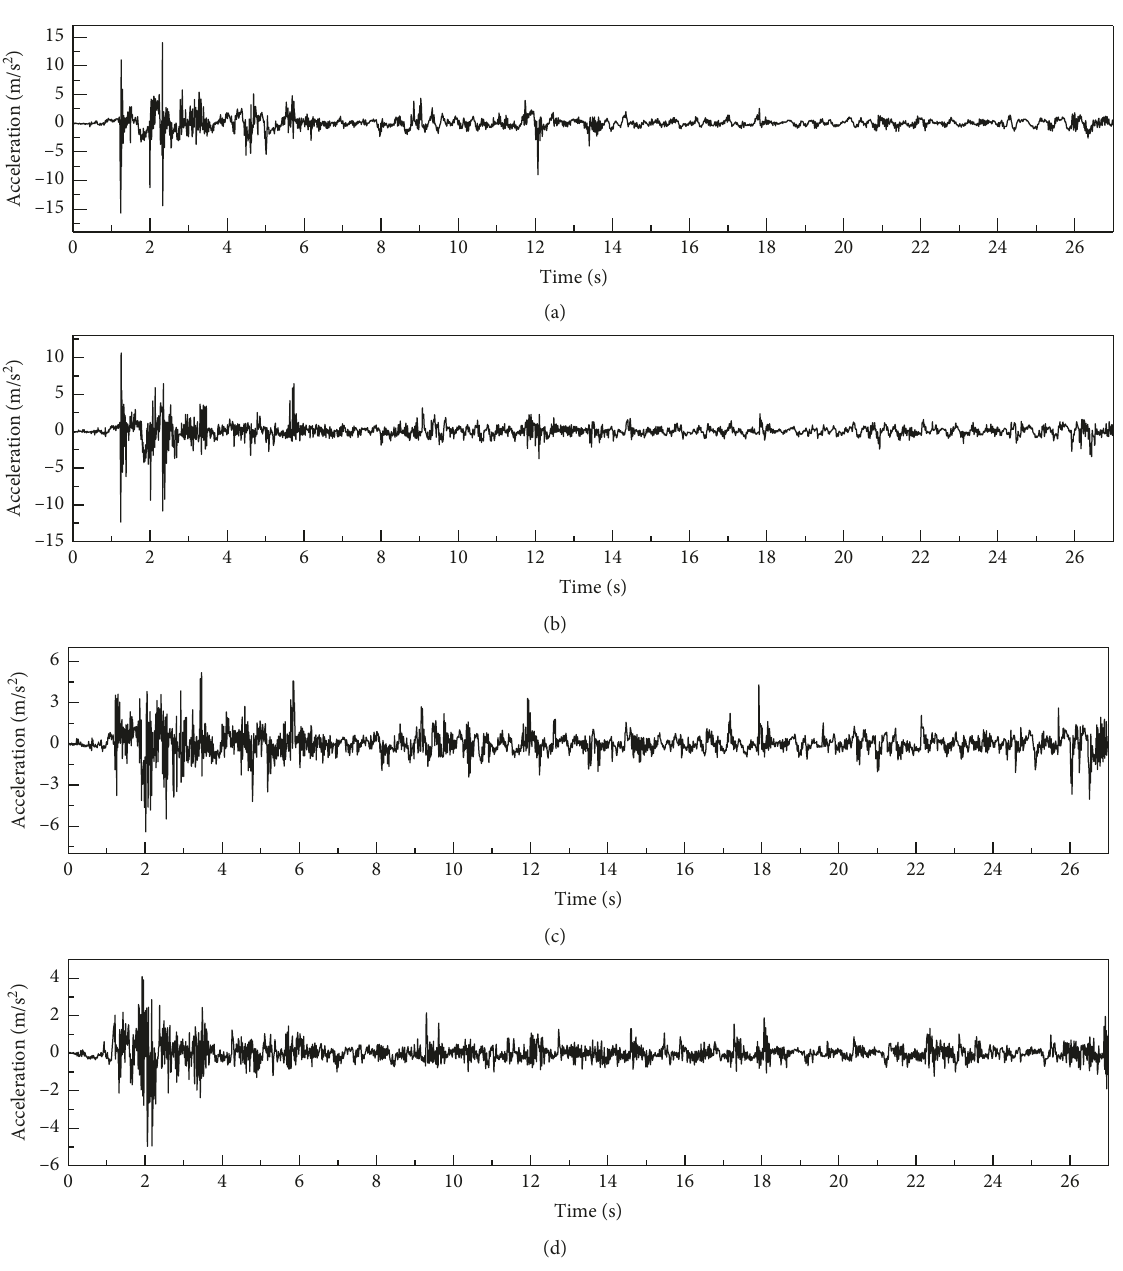
Figure 12: Soil acceleration time-history curve. (a) Depth 28m. (b) Depth 20 m. (c) Depth 10m. (d) Depth